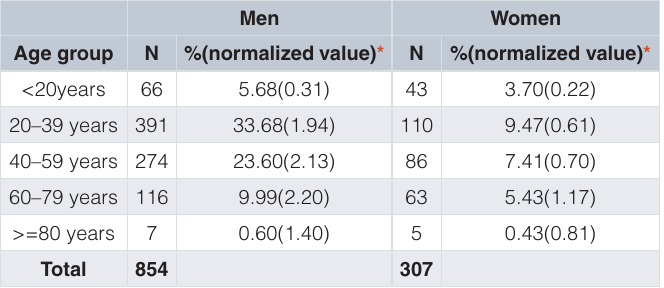
Table 1. Distribution of COVID-19 patients in India confirmed until 14 April 2020 across different age groups and gender (n=1161).